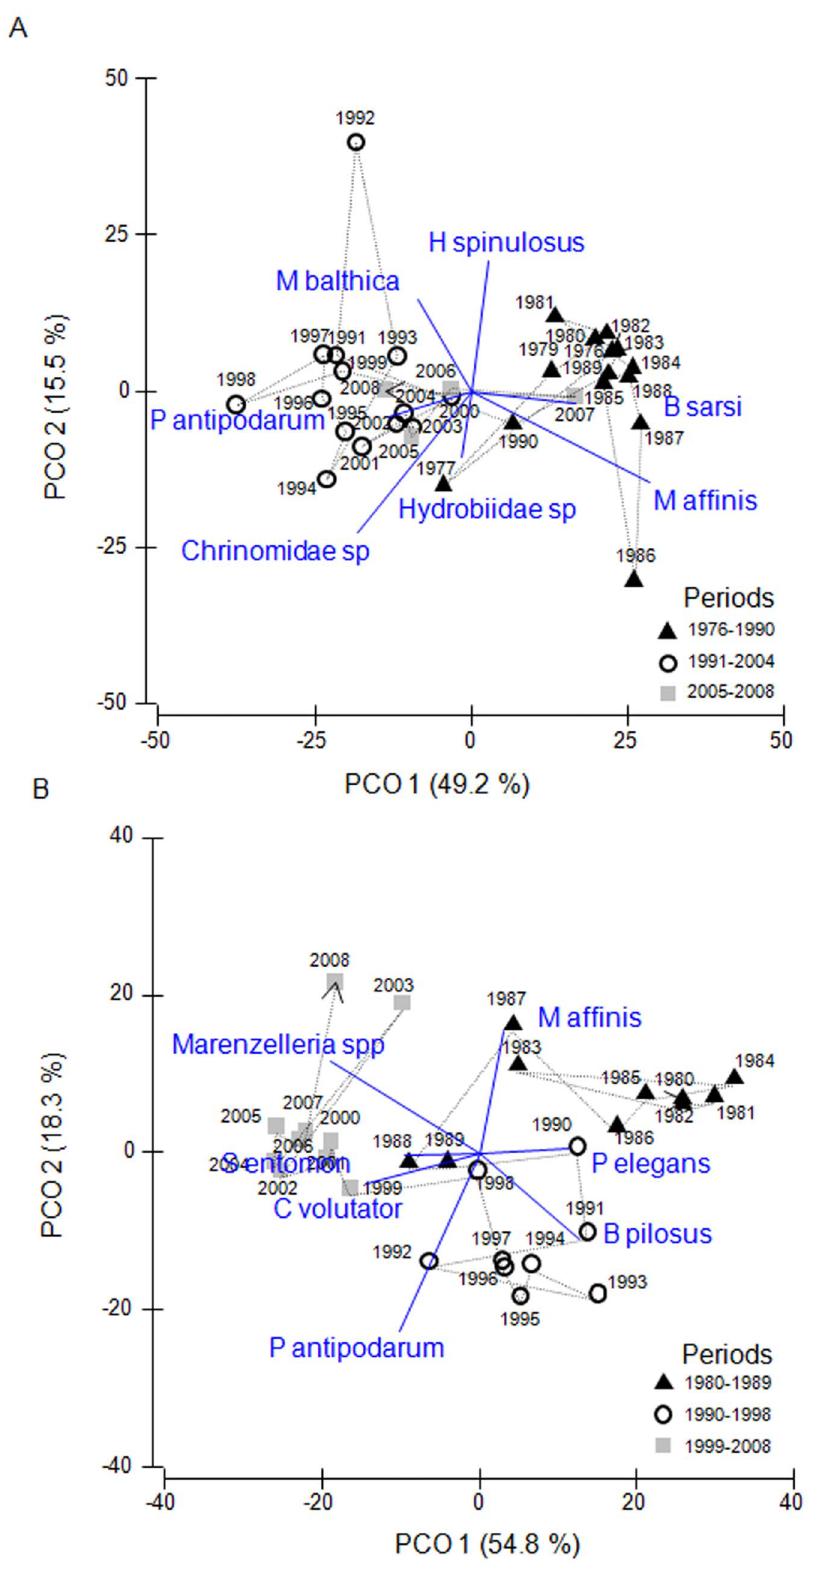
Figure 4. PCO-ordinations of the two zoobenthos communities assessed. Kva¨do¨fja¨rden (A) and Forsmark (B). The ordinations are based on the Bray-Curtis similarity index and the projected vectors denote the abundance of species with a correlation . 0.2 with any of the two first ordination axes. Years with similar species composition according to the chronological clustering analyses are indicated by the same symbols. The line indicates the temporal trajectory of the community. For abbreviation of species names, see table 2. doi:10.1371/journal.pone.0064767.g004 PLOS ONE | www.plosone.org